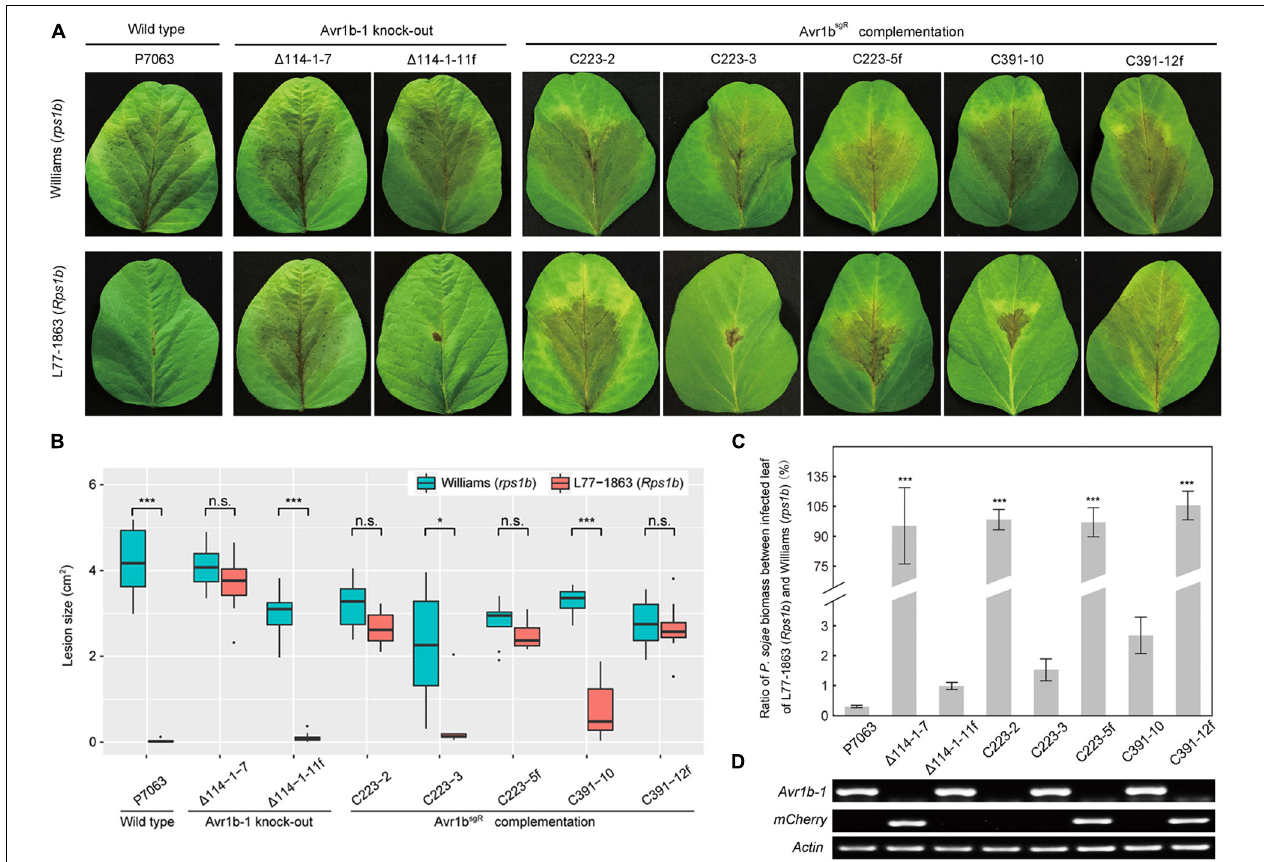
FIGURE 6 | Evaluation of avirulence activity of Avr1b sgR knock-in transformants. (A) Avr1b sgR knock-in transformants (C223-3 and C391-10) and control strains (wild-type P7063, (cid:49) 114-1-7, (cid:49) 114-1-11f, C223-5f, and C391-12f) were tested for avirulence by zoospore inoculation onto unifoliate leaves of Williams ( rps1b ) and L77-1863 ( Rps1b ). Pictures were taken 3 days after inoculation. (B) Average lesion sizes on the leaves of Williams ( rps1b ) and L77-1863 ( Rps1b ) measured on 10 unifoliate leaves from each of three independent experiments. Sizes were measured with ImageJ software. Error bars represent the mean ± standard deviation. P -values were calculated with Wilcoxon rank sum test, * and *** indicate P -value < 0.05 and < 0.001, respectively. (C) Avirulence phenotypes of Avr1b-1 knock-in transformants measured by real-time PCR-based quantification of P. sojae genomic DNA in infected tissue. Proliferation of P. sojae is plotted as the ratio